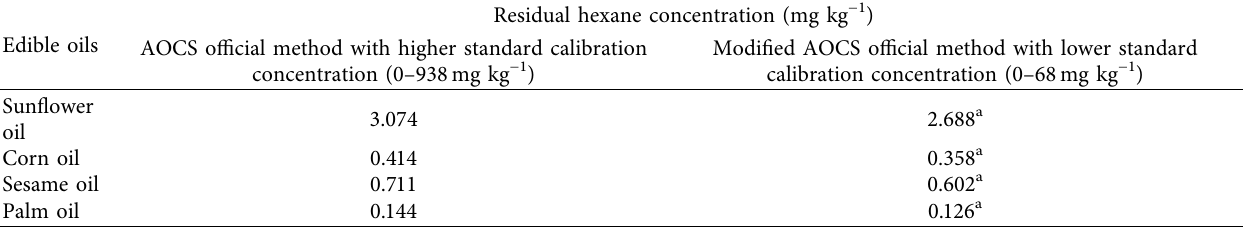
Table 3: Comparison of results of residual hexane in different edible oils.